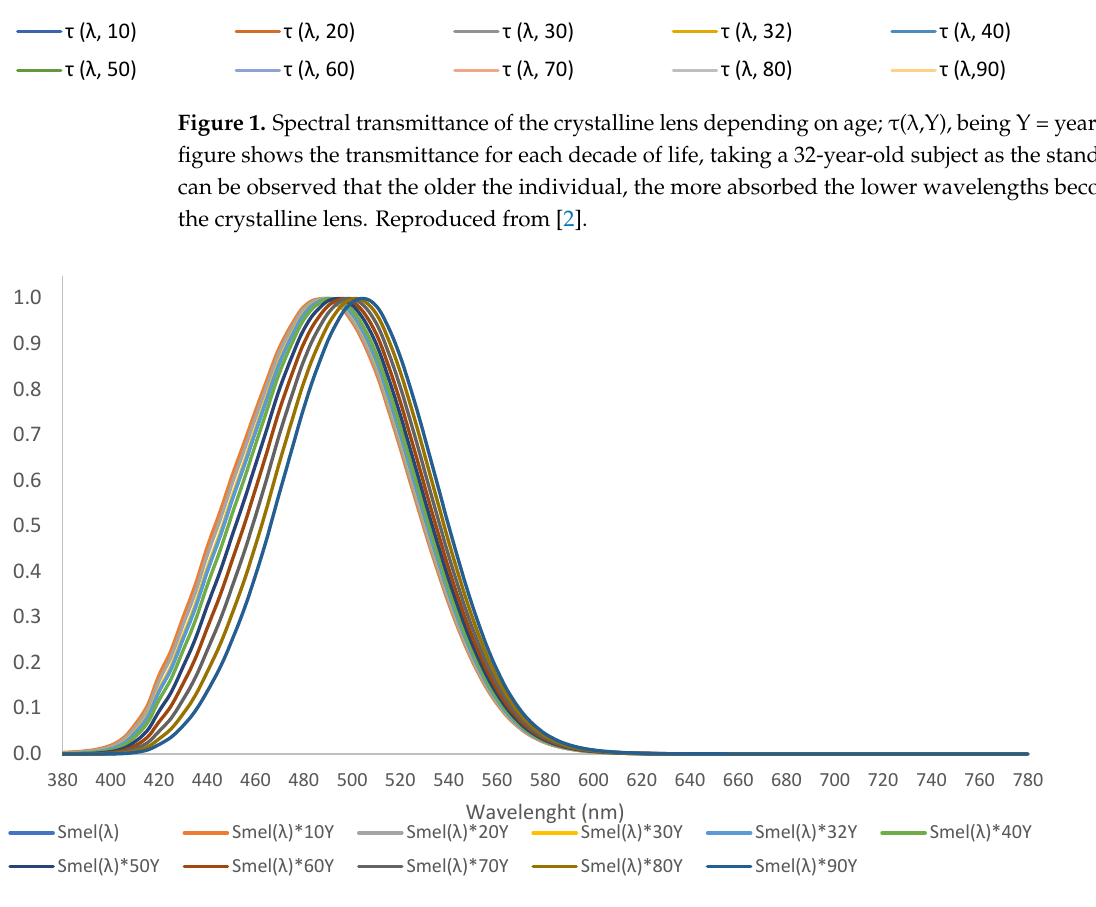
Figure 2. Melanopsin spectral relative sensitivity Smel( λ ) with a maximum at 490 nm and spectrum modified by the absorption of the anterior media of the eye shifted for aged observers (from 10 to 90 years old). Data show Smel( λ max)*10Y at 487nm, Smel( λ max)*20Y at 488nm, Smel( λ max)*30Y at 489nm, Smel( λ max) and Smel( λ max)*32Y at 490nm, Smel( λ max)*40Y at 491nm, Smel( λ max)*50Y at 494nm, Smel( λ max)*60Y at 496nm, Smel( λ max)*70Y at 498nm, Smel( λ max)*80Y at 501nm, Smel( λ max)*90Y at 504nm. Abbreviations: Smel( λ ), melanopsin spectra modified by ipRGCs’ (intrinsically photosensitive retinal ganglion cells) absorption; Y = years.